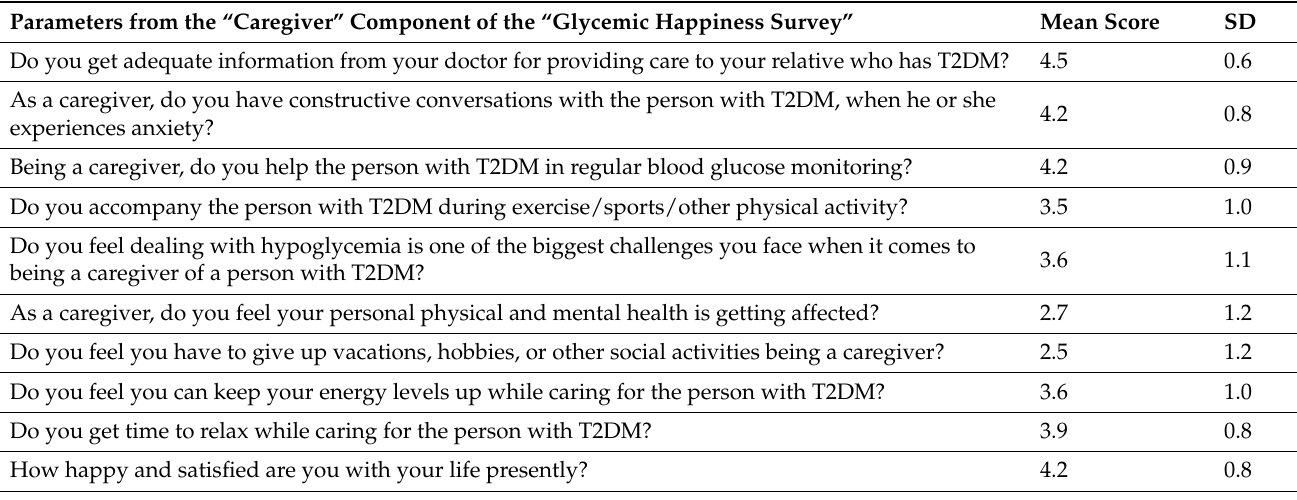
Table 4. Mean Likert scale scores from the caregiver component of the glycemic happiness survey ( N = 167). Parameters from the “Caregiver” Component of the “Glycemic Happiness Survey”